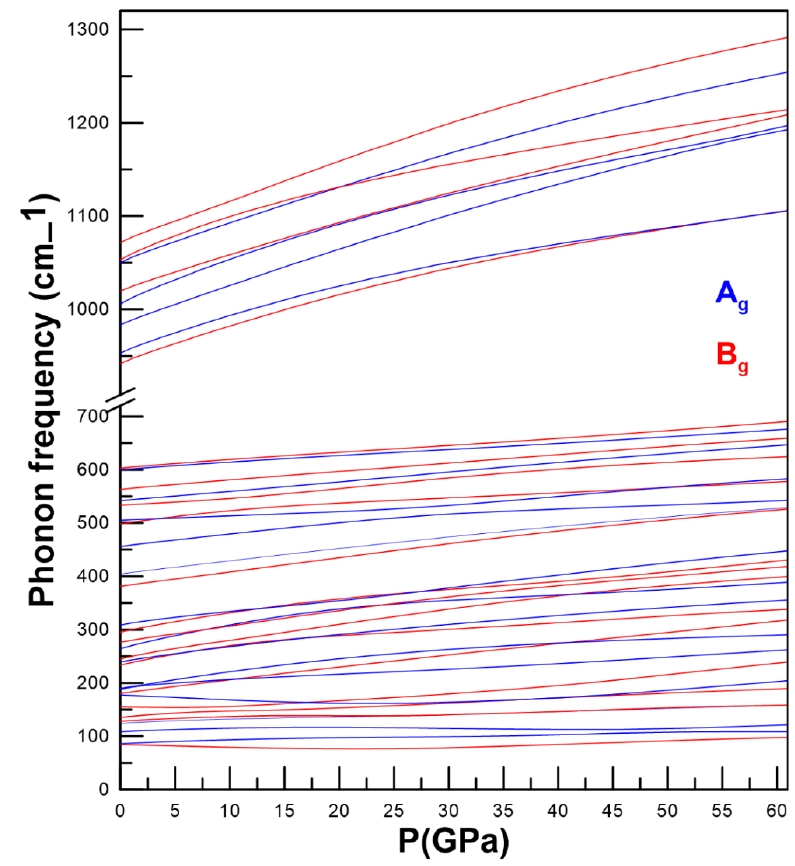
Figure 10. (Color online) Pressure dependence of the Raman modes of monazite-type GdPO 4. Figure 10. ( Color online ) Pressure dependence of the Raman modes of monazite-type GdPO